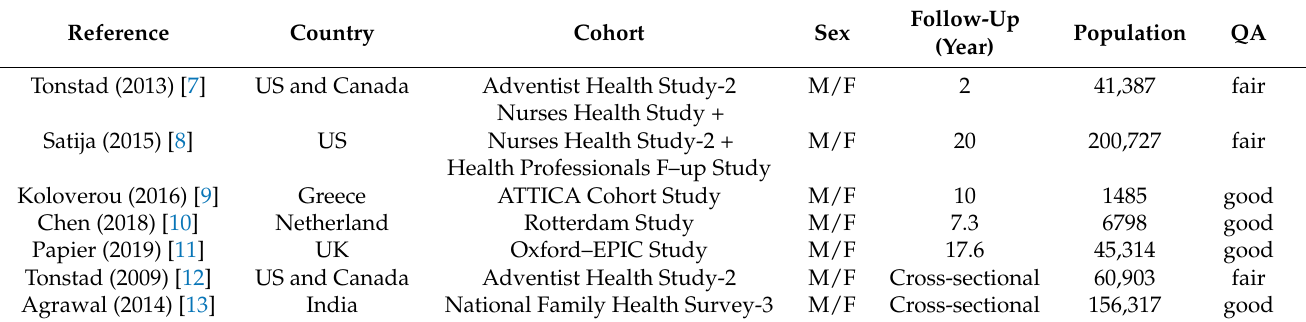
Table 1. Characteristics of observational